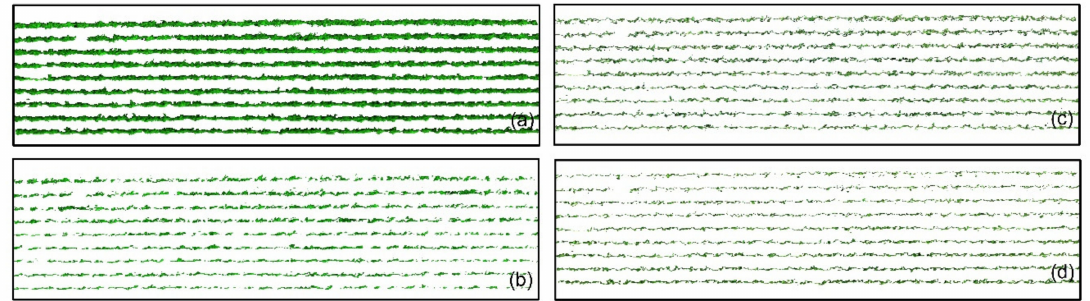
Figure 6. Subsets of grapevine canopy zones extracted from the hyperspectral image. ( a ) Entire grapevine canopy, ( b ) sunlit (slt) canopy zone, ( c ) nadir (ndr) canopy zone, ( d ) shaded (shd) canopy